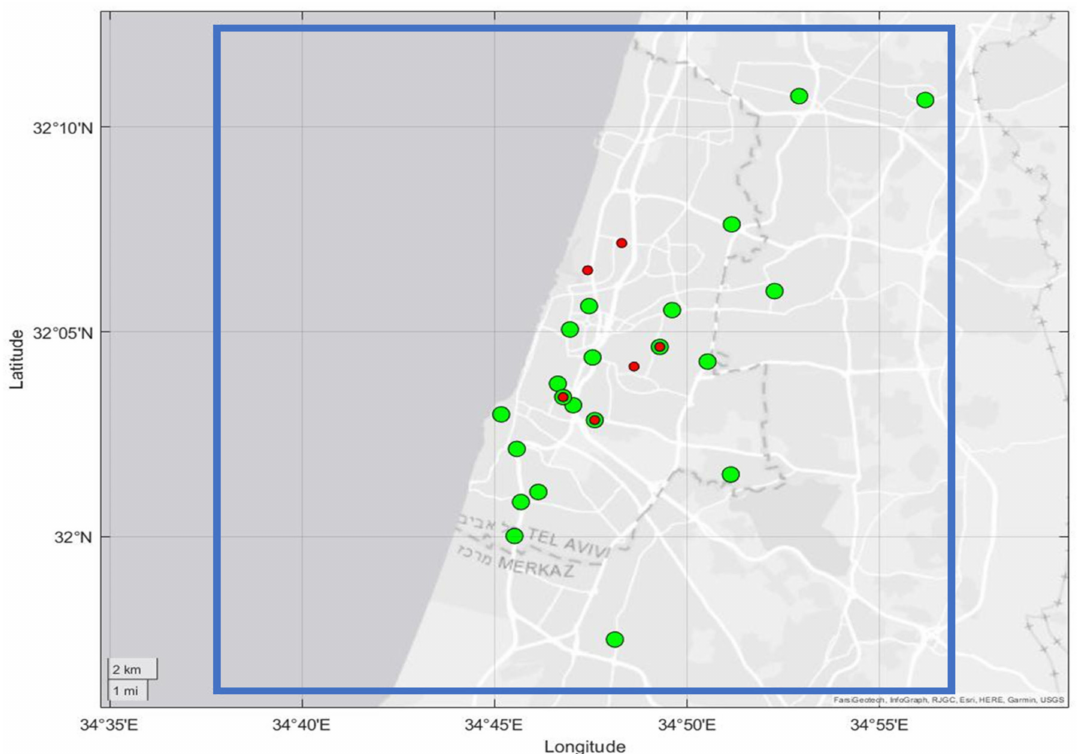
Figure 1. Research area of the Tel-Aviv metropolitan area and air-monitoring stations used in the present study. During the research period, there were 21 active monitoring stations with continuous PM2.5 records (green dots) and only 6 with PM10 records